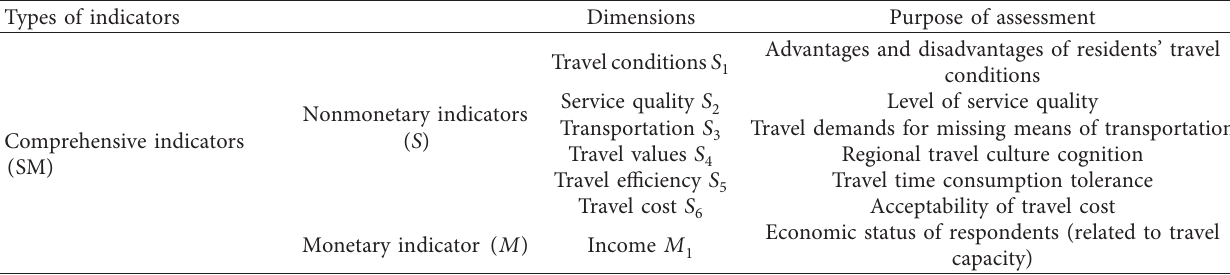
Table 1: Distribution of travel deprivation questionnaire.